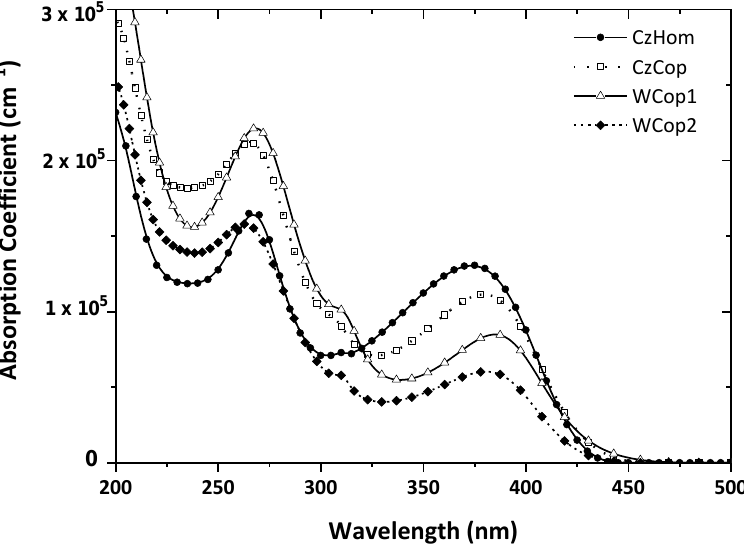
Figure 4. The absorption coefficient of the studied films calculated using the best-fit parameters derived by SE analysis procedure.